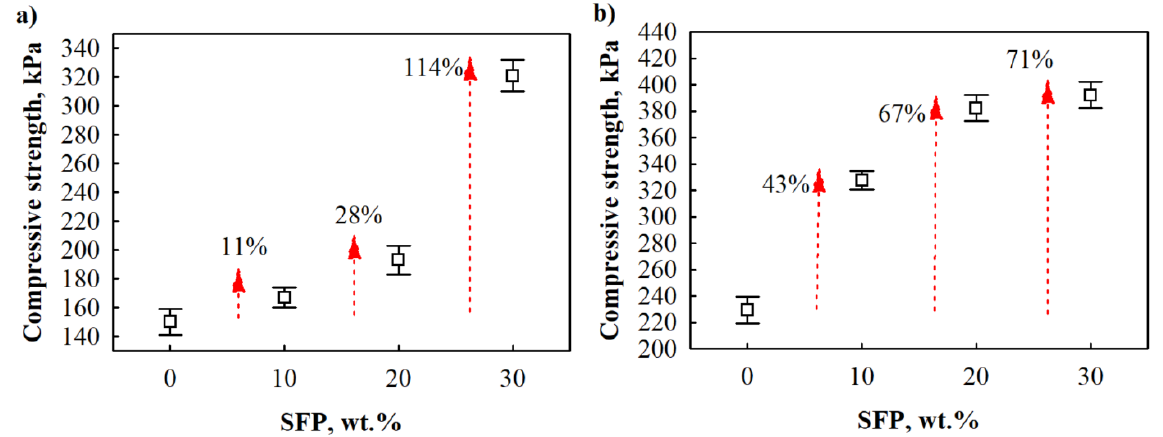
Figure 5. Compressive strength of SFP filler-modified PUR foams: ( a ) perpendicular to foaming direction and ( b ) parallel to foaming direction.